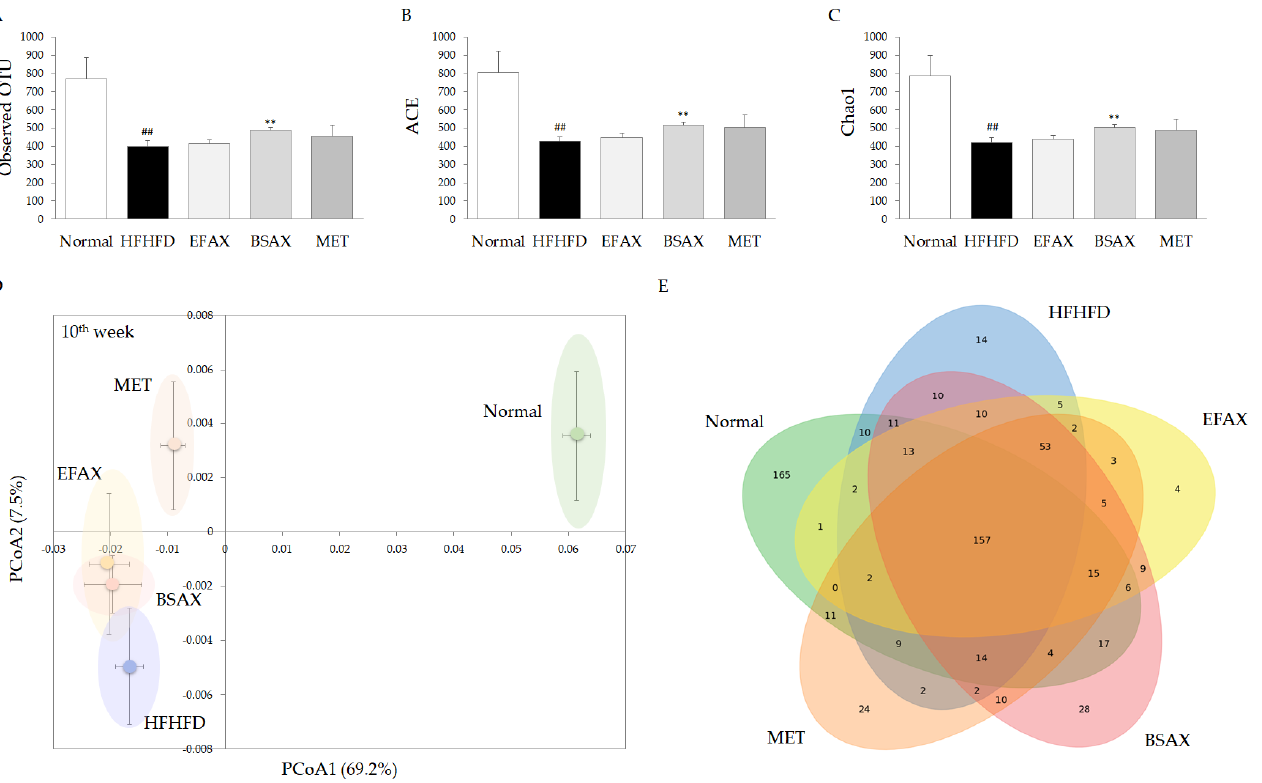
Figure 5. The gut microbiota was significantly resilient and was recovered by BSAX. ( A − C ) Alpha diversity indices (observed OTU, ACE, and Chao1 indices) for the gut microbiota analysis. ( D ) PcoA analysis of the fecal 16s rDNA sequencing data was conducted and diagramed to evaluate the similarities among the groups. ( E ) The Venn diagram illustrates the number of each group’s shared and unique species in the gut microbiota. ## p < 0.01, compared with the normal group; ** p < 0.01, compared with the HFHFD